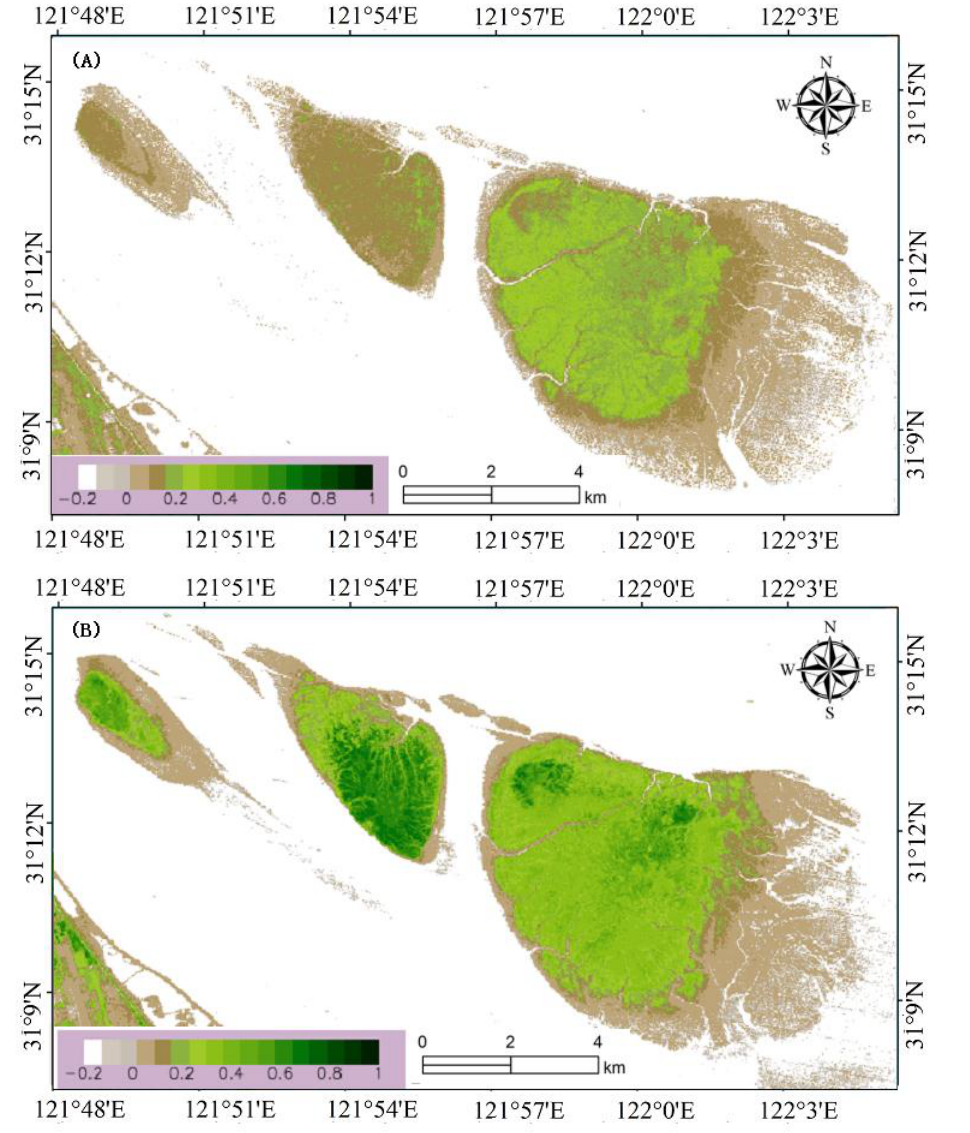
Figure 2. The NDVI values at Jiuduansha Wetland in 2012: ( A ) The NDVI on 25 March 2012; ( B ) the NDVI on 16 May